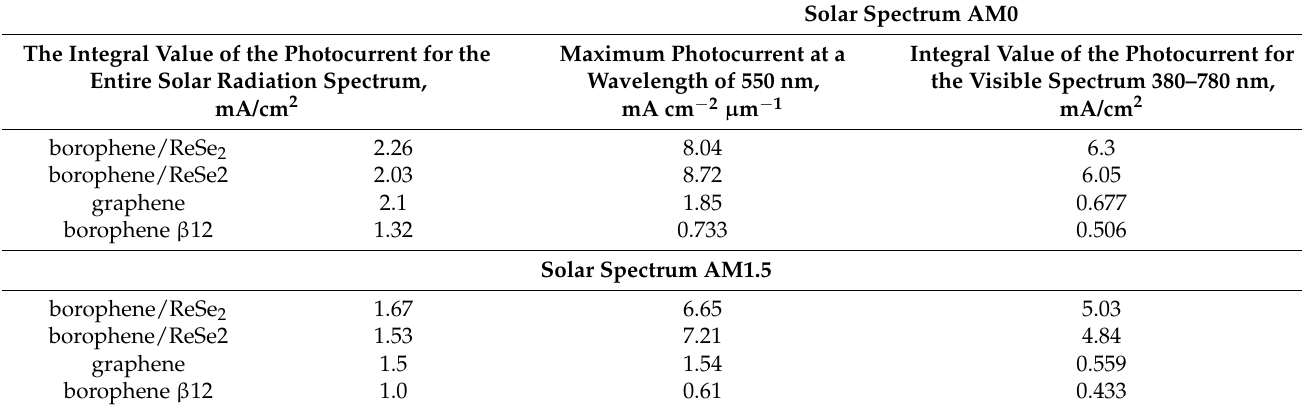
Table 1. Some optoelectronic characteristics of van der Waals borophene/ReS 2 and borophene/ReSe 2 heterostructures.